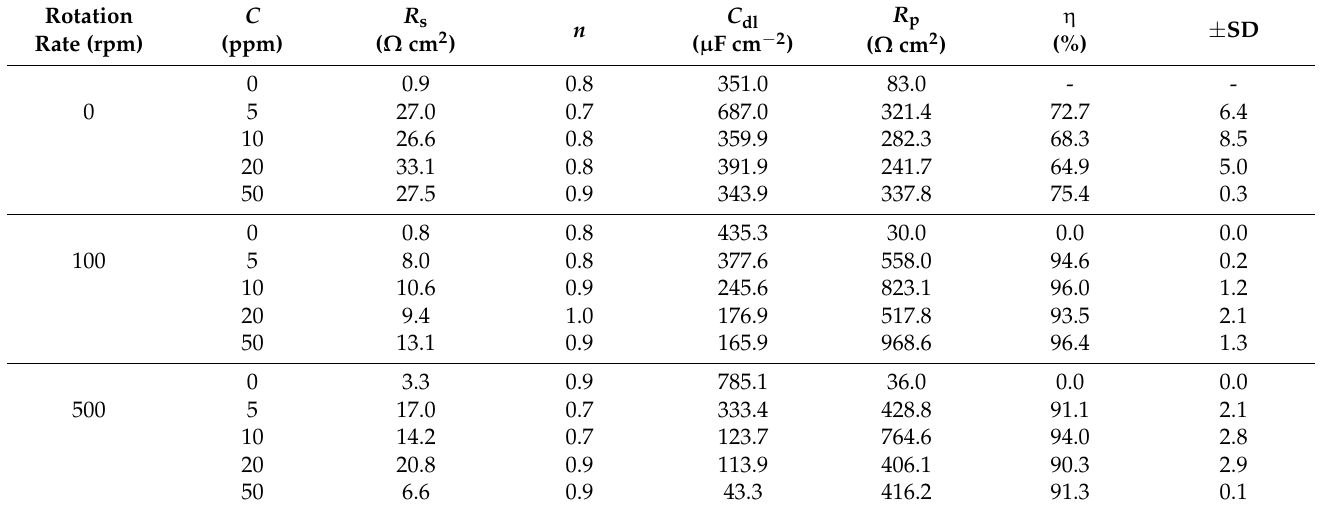
Table 1. Electrochemical parameters of 4-PC as a corrosion inhibitor in 1018 steel at different rotation rates, immersed in 3% NaCl + CO 2